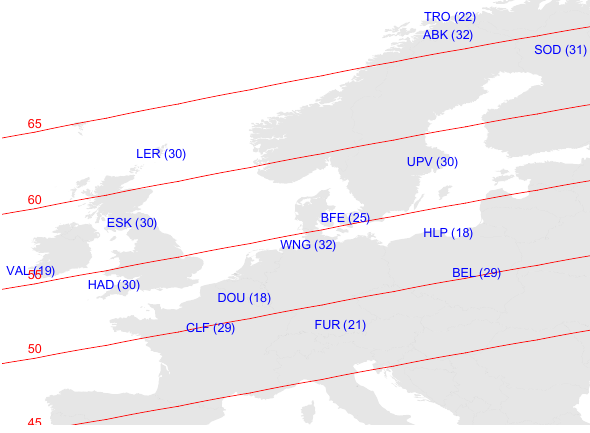
Figure 1. The locations of the magnetic observatories used. Each observatory has at least 18years of contiguous 1-min data and the number of years of available data is shown in parenthesis. The red curves mark the geomagnetic latitudes, using the 11th generation IGRF coefficients, for epoch 1 January